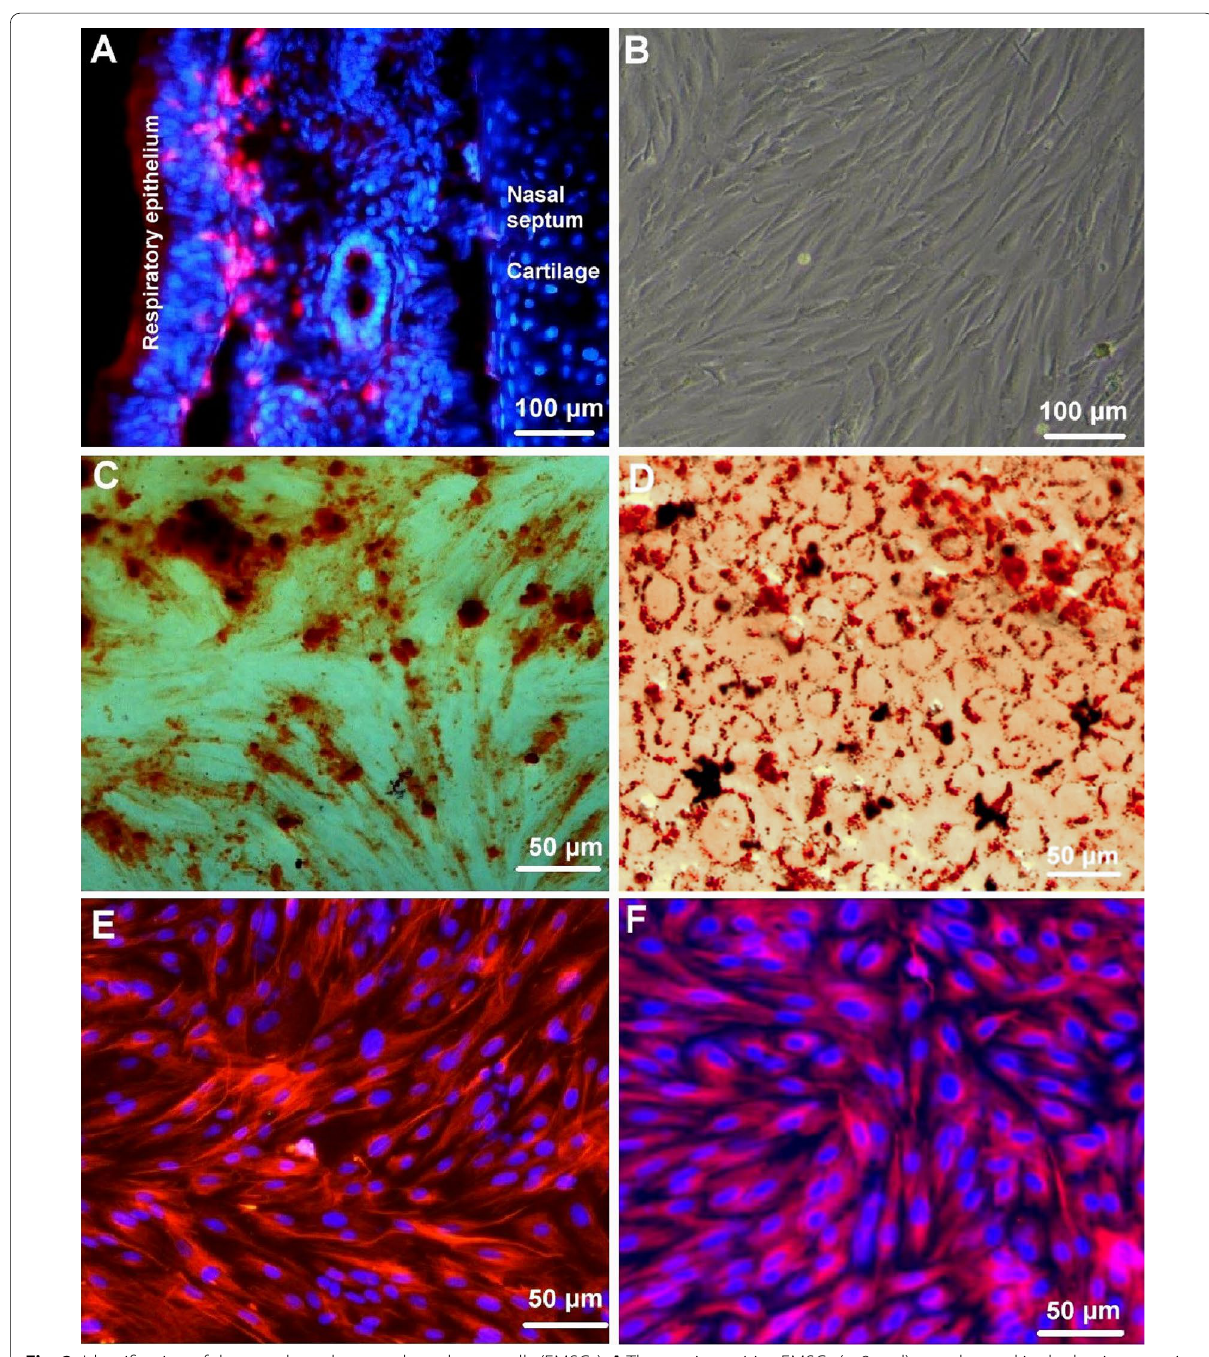
Fig. 2 Identification of the ectodermal mesenchymal stem cells (EMSCs). A The nestin positive EMSCs (cy3, red) were located in the lamina propria under the respiratory epithelium of the nasal septum; B A phase-contrast image showed that the cultured EMSCs at the third passage appeared as fibroblastic-like cells and proliferated rapidly on plastic plates; C The osteogenic differentiated EMSCs in osteogenic medium were stained by alizarin red; D The adipogenic differentiated EMSCs in adipogenic-induction medium were stained by with oil red-O; E , F Immunofluorescence staining of the neural crest cell markers showed that almost all of the EMSCs expressed nestin and vimentin. The IgG-Cy3 (red) was used as the second antibody for the immunofluorescence staining and the nuclei were counter-stained with Hoechst 33342